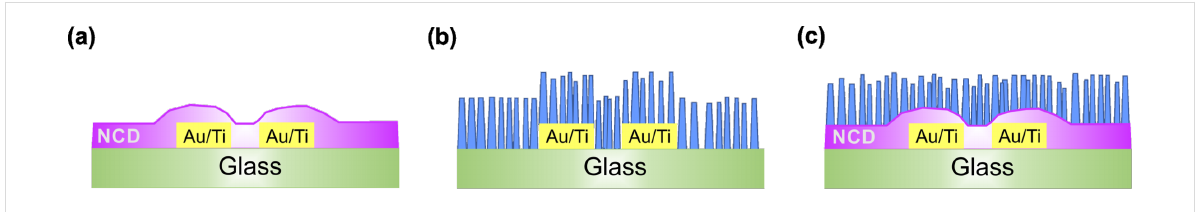
Figure 1: Schematic drawing of the sensor assembly designs: (a) continuous NCD film, (b) ZnO nanorods, and (c) ZnO nanorods combined with NCD thin layer.